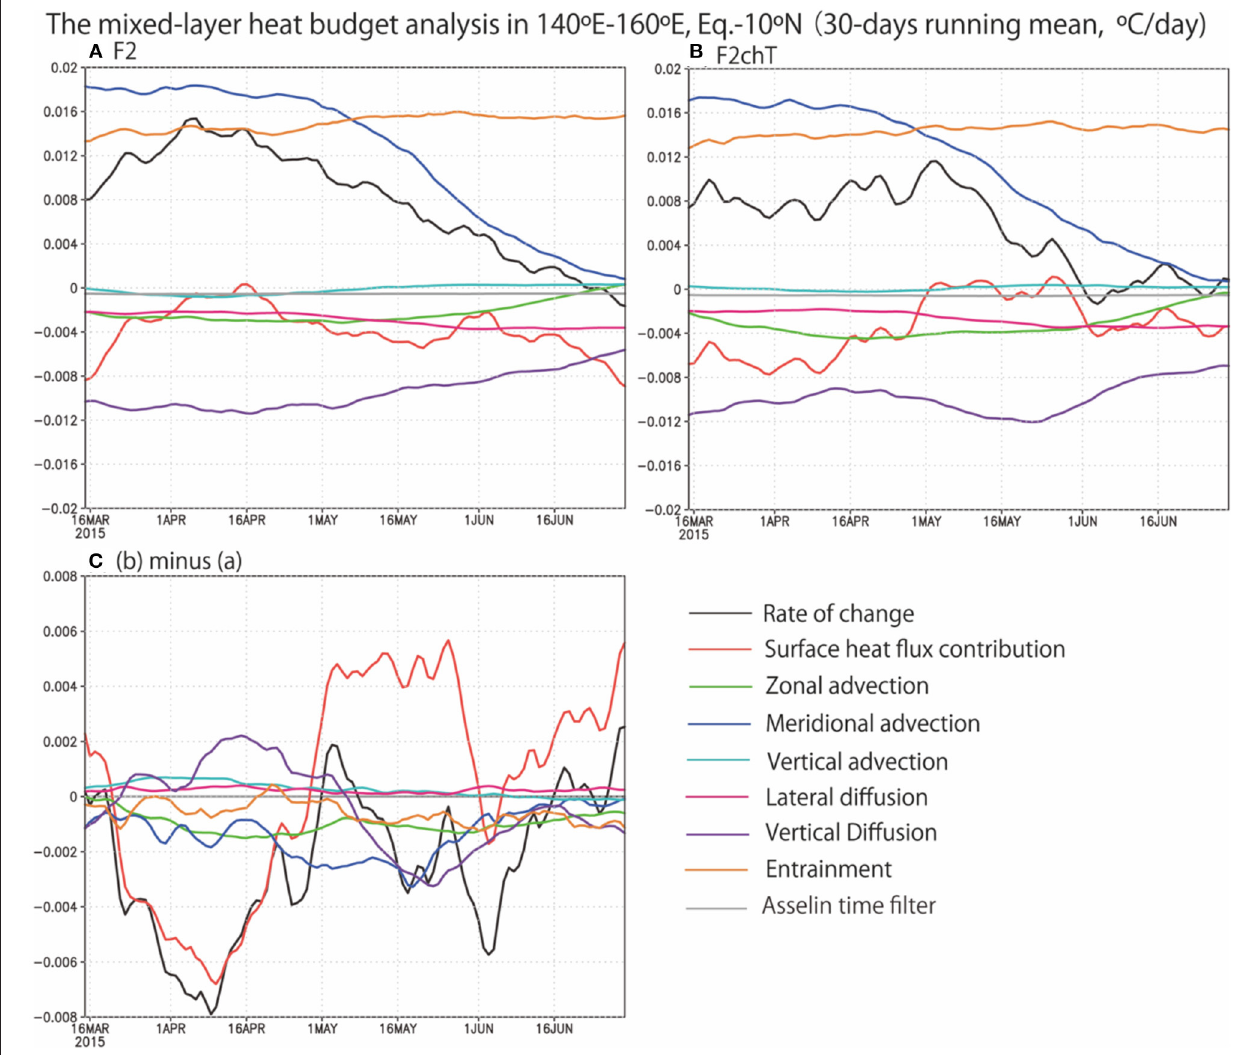
FIGURE 5 | (A) The mixed-layer heat budget analysis ( ◦ C/day) averaged in 140 ◦ E–160 ◦ E, equator − 10 ◦ N of the ensemble mean predictions by F2 after 30-days running mean of the daily outputs. Total rate of change, contributions from the surface heat flux, zonal advection, meridional advection, vertical advection, vertical diffusion, lateral diffusion, entrainment, and Asselin time filtering are shown by black, red, green, blue, light blue, purple, magenta, orange, and gray lines, respectively. (B) Same as (A) , but for F2chT. (C) (B) minus (A)